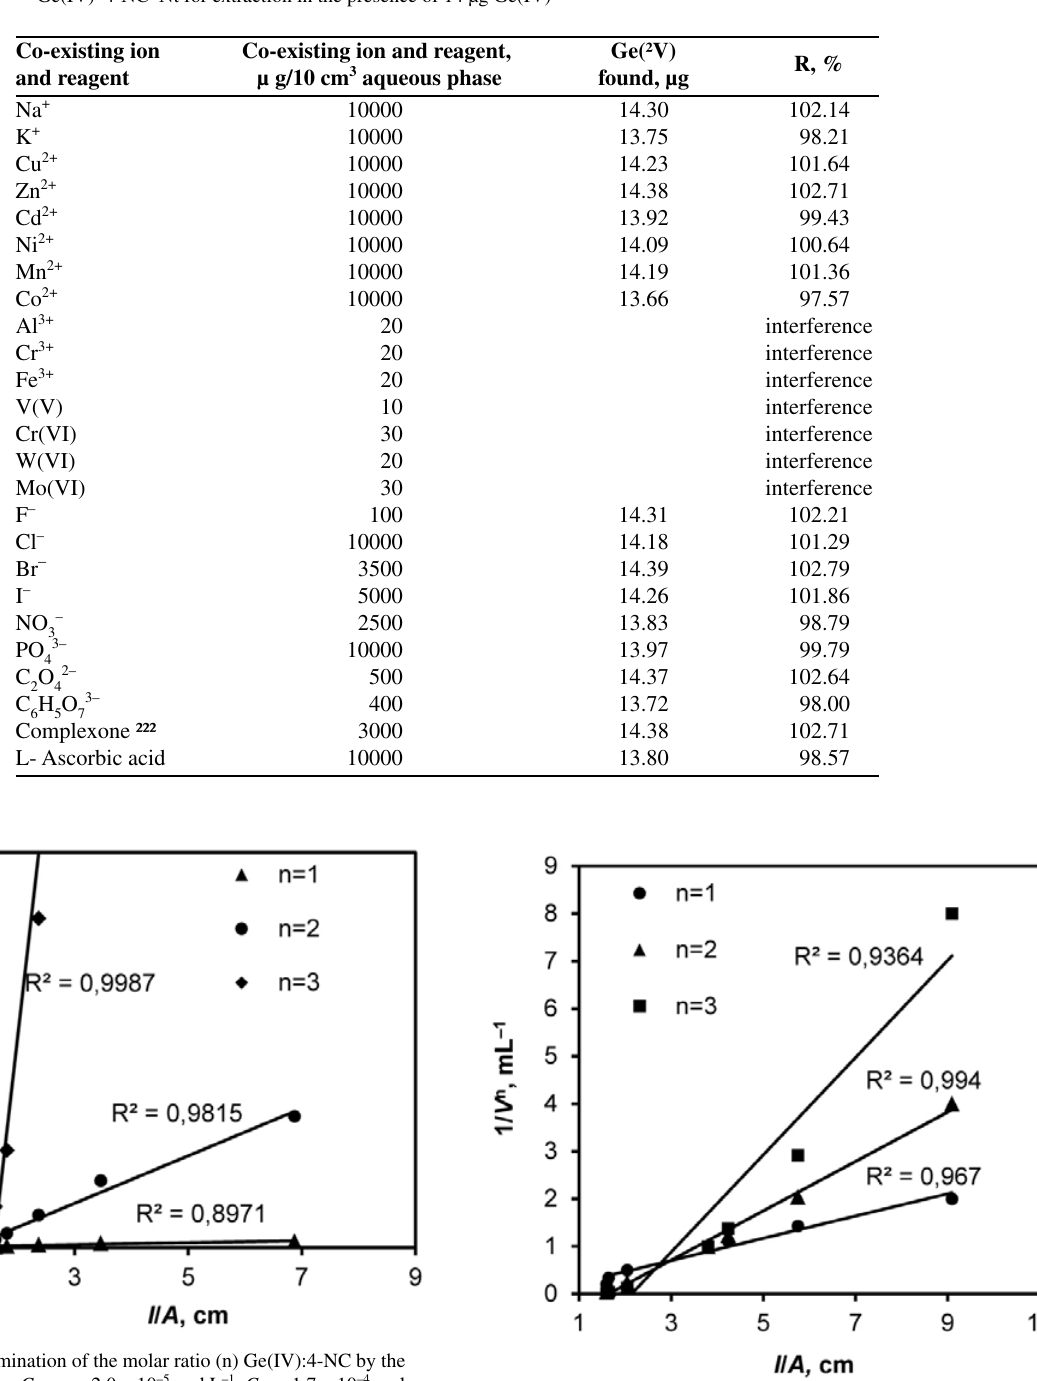
Table 2. Effect of co-existing ions and reagents on the complex formation of the ion-associate Ge(IV)–4-NC–Nt for extraction in the presence of 14 μg Ge(IV)